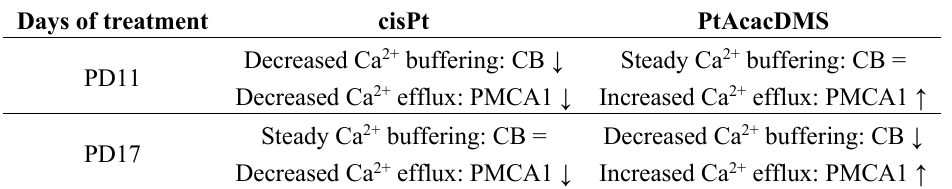
Table 2. Summary of the trends in the immunocytochemical indicators for CB and PMCA1 in the DG granule cells with respect to controls following cisPt or PtAcacDMS treatment and the ensuing impact on [Ca 2+ ] i